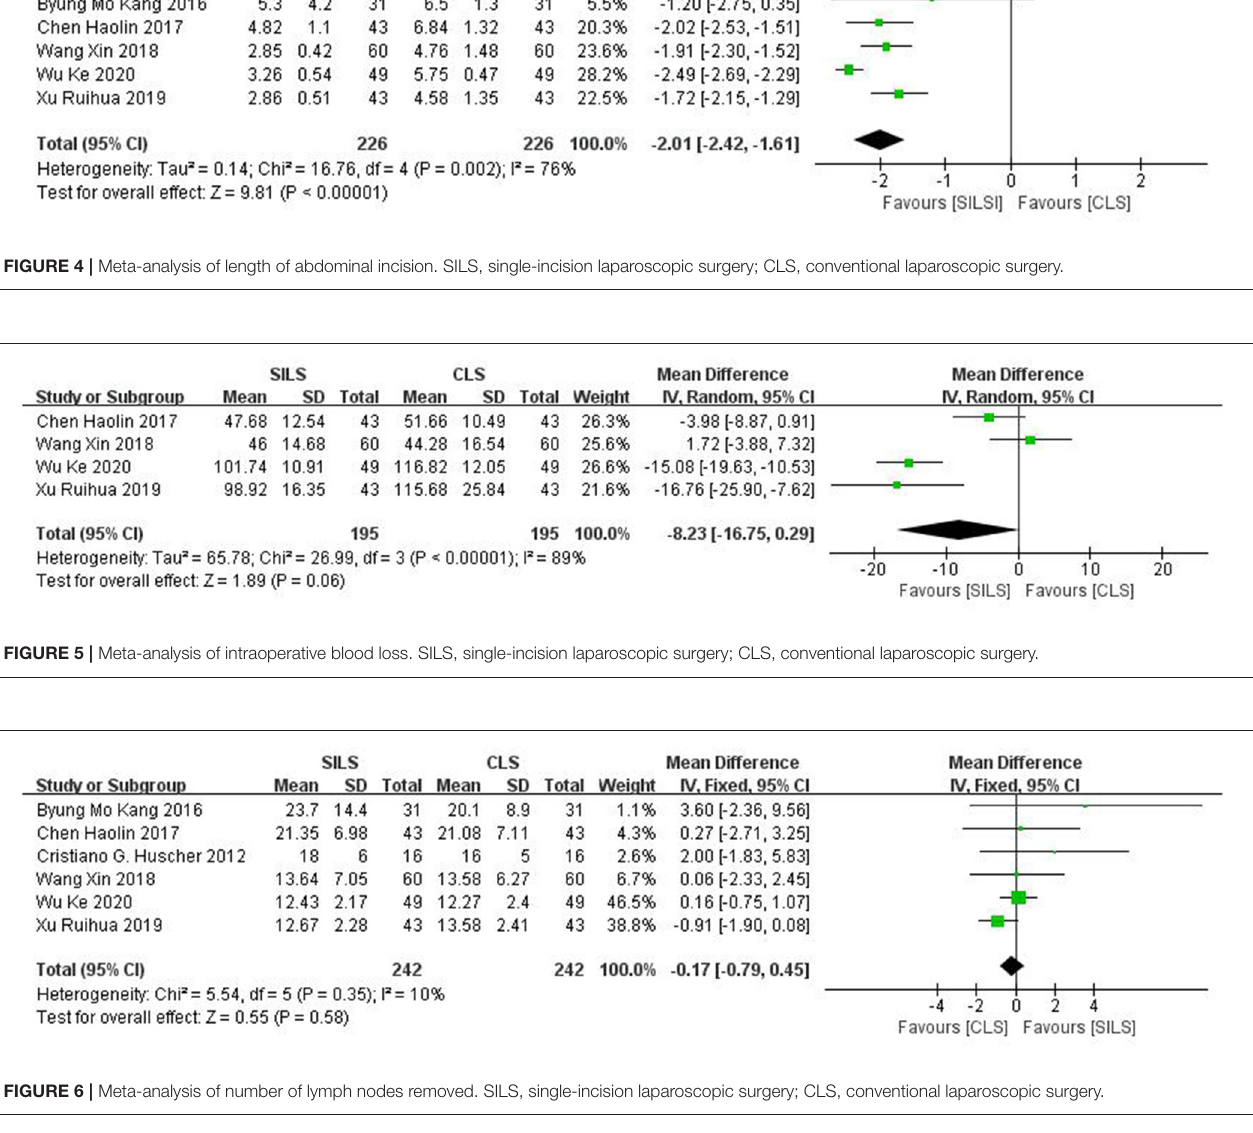
Frontiers in Surgery | www.frontiersin.org